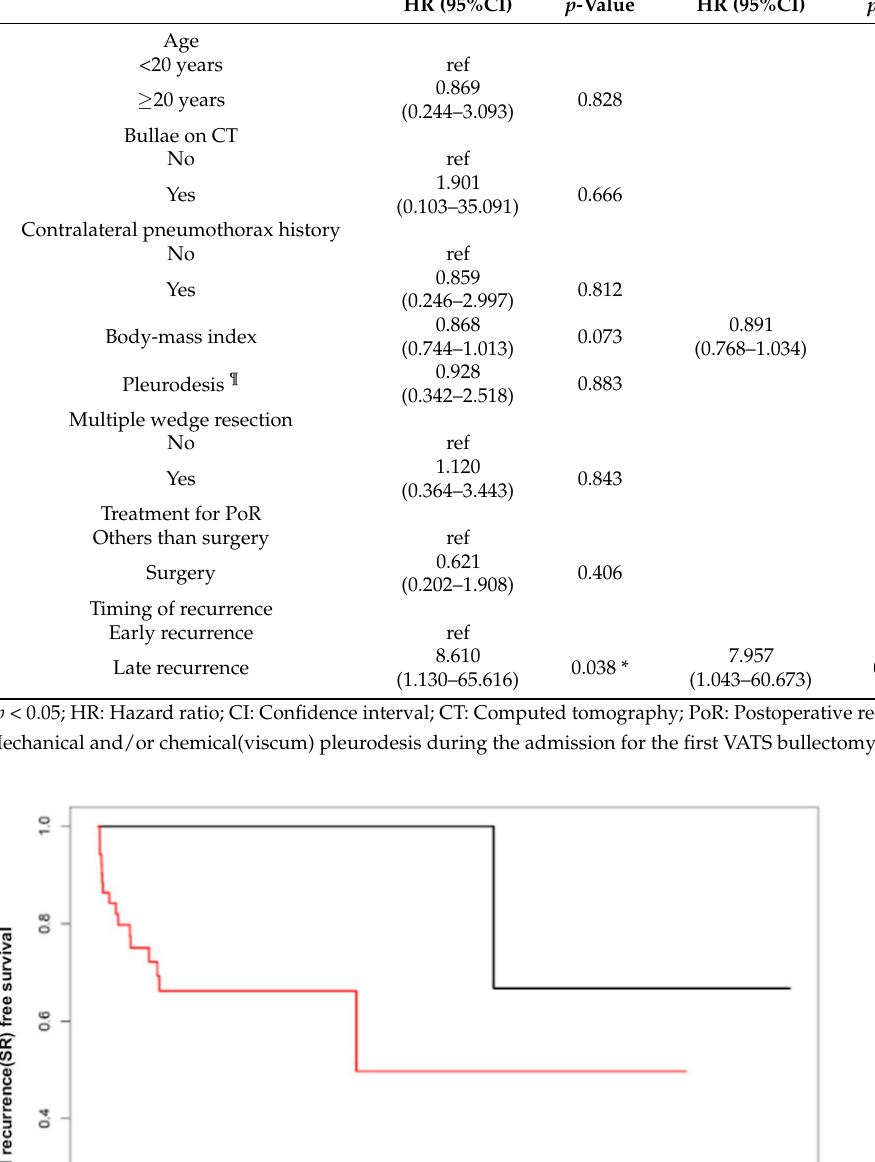
Figure 3. Kaplan–Meier curve of early recurrence and late recurrence (cut-off: 23 days). 4. Discussion This study analyzed 77 cases of PoR and explained that the temporal patterns of re- currence might be predictive of SR. As we described in Figure 1, 27.3% (21/77) of the cases of PoR occurred within 30 days after surgery. This result is similar to the findings of Bro- phy et al., which showed that 26.3% (10/38) of PoR occurred within 30 days after surgery [8]. Moreover, patients in the ER group showed a better prognosis in terms of developing recurrent pneumothorax down the road than those in the LR group, and the period be- tween surgery and recurrence played a significant prognostic factor. To date, there has not been a clear consensus on the definition of postoperative re- currence of PSP. Brophy et al. described a “true” postoperative recurrence as an episode that occurs at least 15 days after surgery and classified repetitive pneumothorax within 15 days as a “prolonged air leak” [8]. Onuki et al. defined recurrence as an episode occurring at least 30 days after surgery and thought that recurrent events within the first 30 days after surgery were part of the staple-healing process [10]. On the other hand, Hsu et al. considered any recurrence at any time after an operation to be PoR [7], while Kim et al. considered a one-year mark as the cutoff to define early recurrence [11]. However, to the best of our knowledge, no study has evaluated the relationship between different clinical